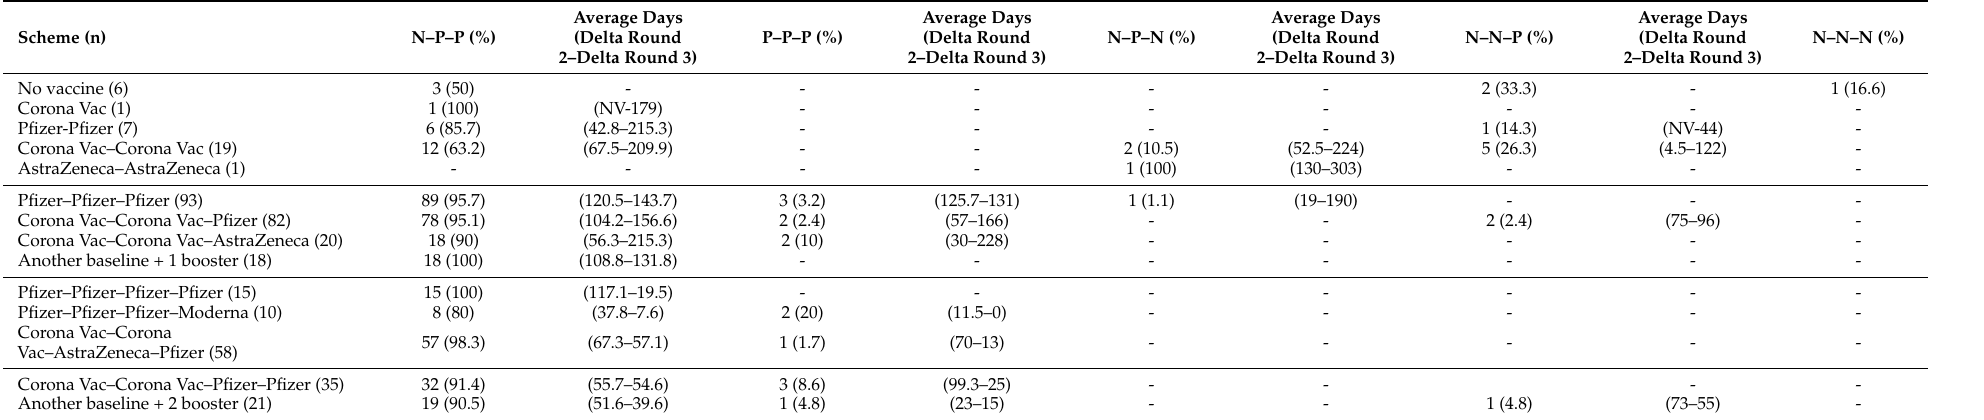
Table 4. SARS-CoV-2 antibody seroprevalence rates in each round of follow-up and average number of days between administration of the last vaccine and sample collection in each